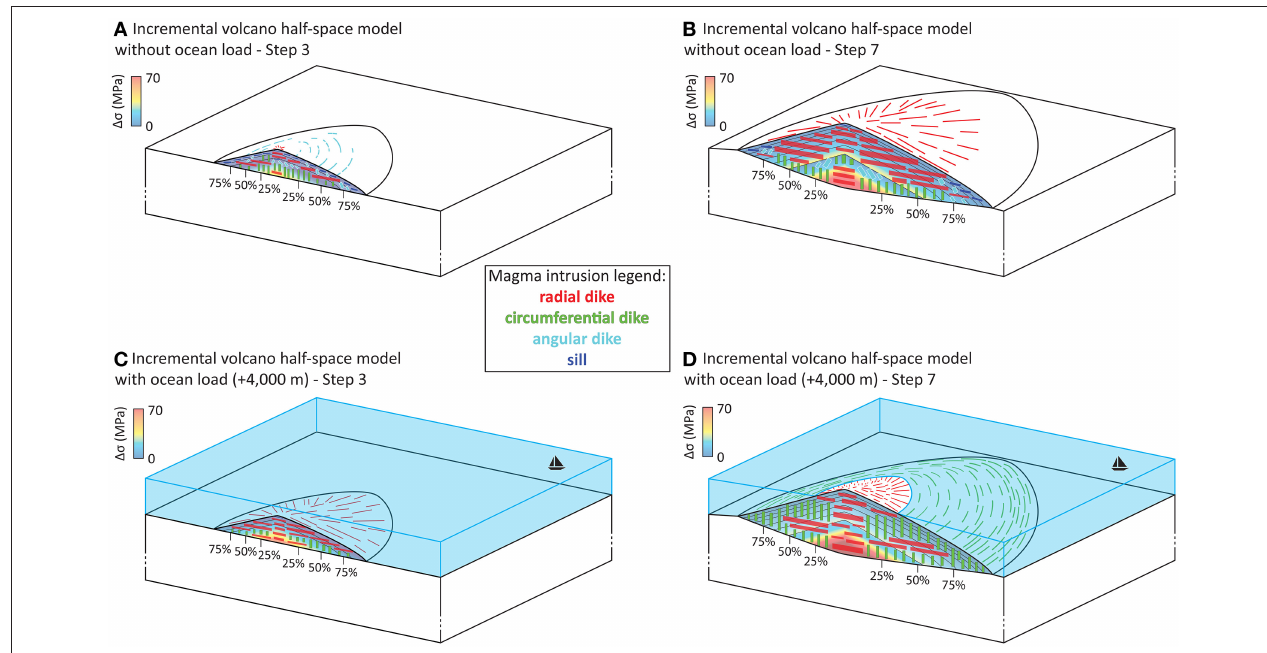
FIGURE 6 | Sketch illustrating the state of stress and the type of magmatic intrusions within incrementally-grown volcanoes for half-space models. Steps 3 (A) and 7 (B) of the model without an ocean load. Steps 3 (C) and 7 (D) of the model with an ocean load ( + 4,000m). Legend as in Figure 4